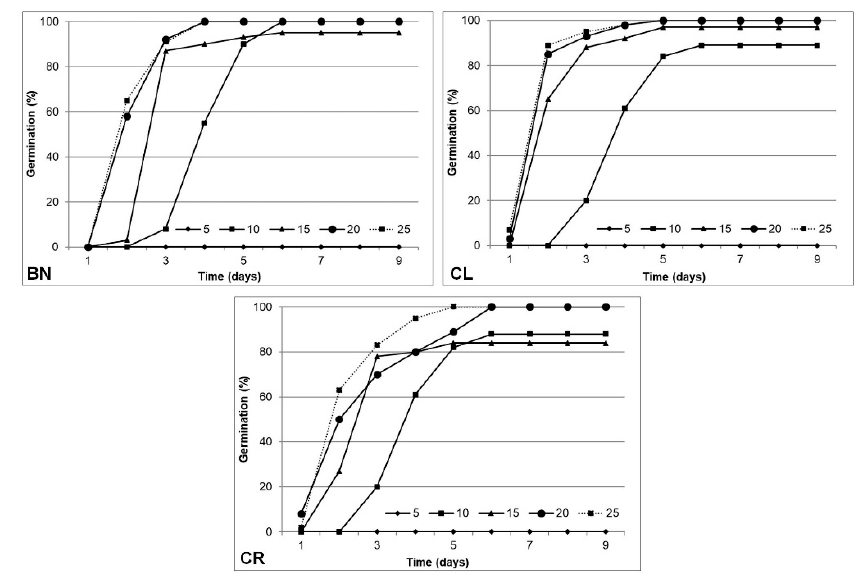
Figure 1. Progress of germination percentage (%) of BN, CL and CR seeds in relation to temperature (5, 10, 15, 20 and 25 ◦ C). Each point represents the mean of four replications of 50 seeds. Table 2. E ff ect of growing temperature on the mean germination time (MGT) of studied genotypes. MGT